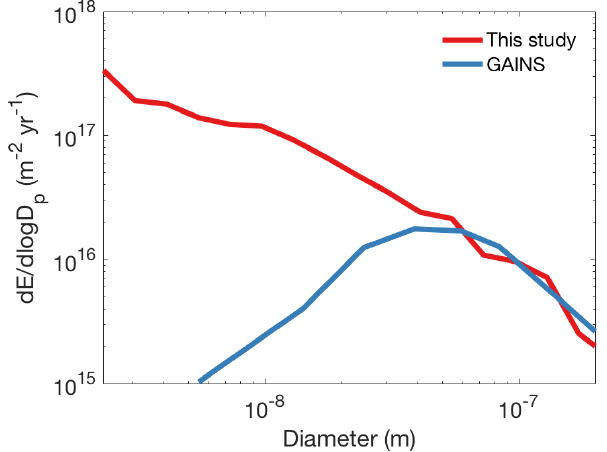
Figure 9. Annual sum of particle number emissions at different sizes (normalized with the width of each size bin) based on par- ticle number emissions calculated for non-NPF event days in this study (red line) and the GAINS model (blue line). In this study, the emissions to the smallest sizes include the contribution from atmo- spheric clustering, which is not considered in the GAINS